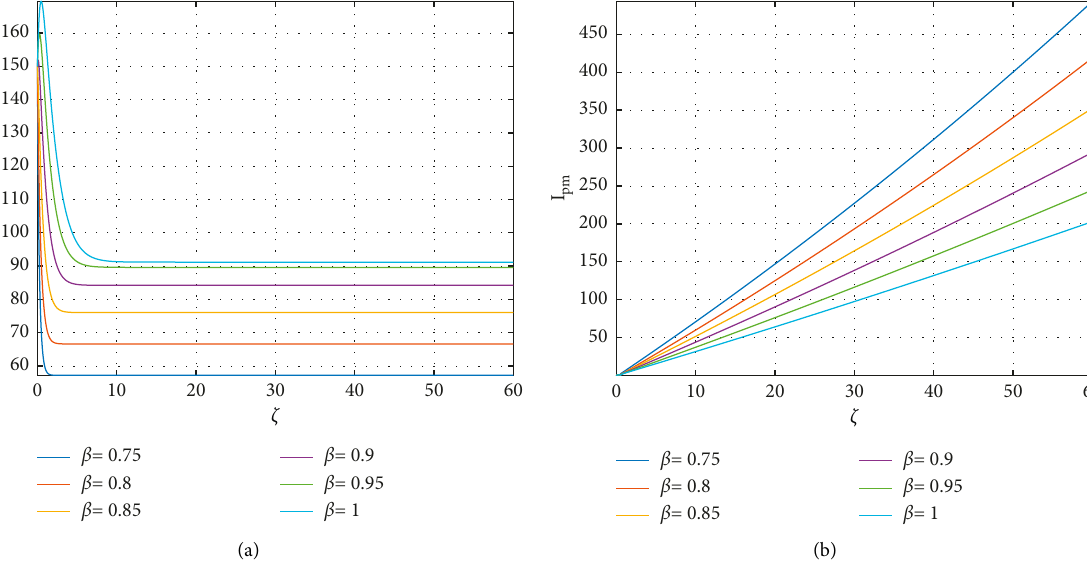
q � 0 . 06, ρ ∈ [ 0 . 1 , 0 . 9 ] with pm when 2 2